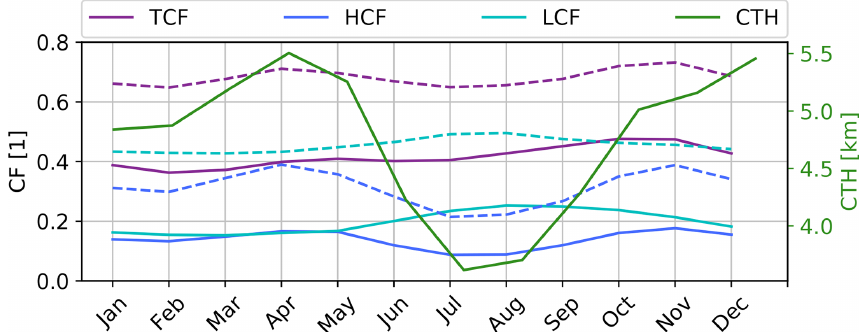
Figure 2. Domain-averaged tropical Atlantic climatologies of TCF, HCF, LCF, and CTH. The dashed lines indicate climatologies of the DARDAR data (June 2006–June 2016) and the solid lines indicate MODIS data (September 2002–June